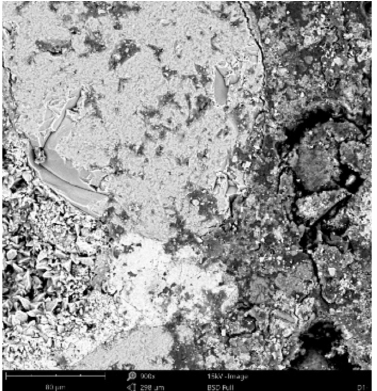
Figure 22. Phenom XL Desktop SEM photos.